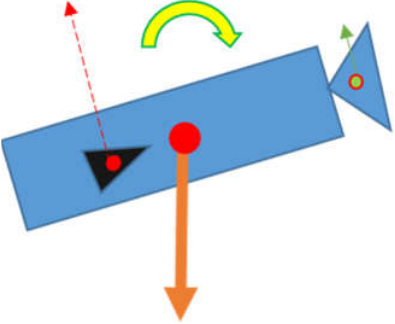
Figure 3. We change slightly to generate a moment, and the body rotates in the clockwise direction.